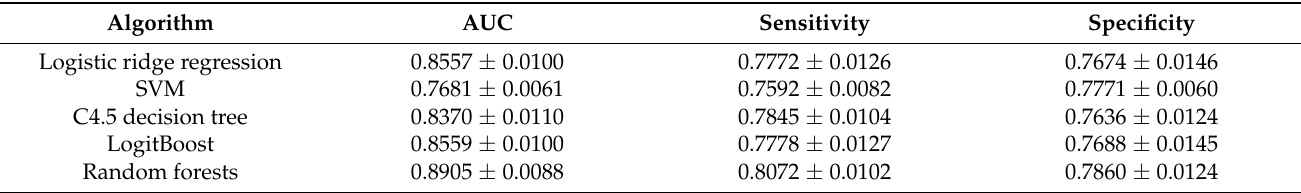
Table 4. The results of repeated 10-fold cross-validation experiments with a synthetic minority oversampling technique for differentiating MDD patients from healthy individuals, using logistic ridge regression, SVM, C4.5 decision tree, LogitBoost, and random forests with biomarkers such as eight clinical variables and 17